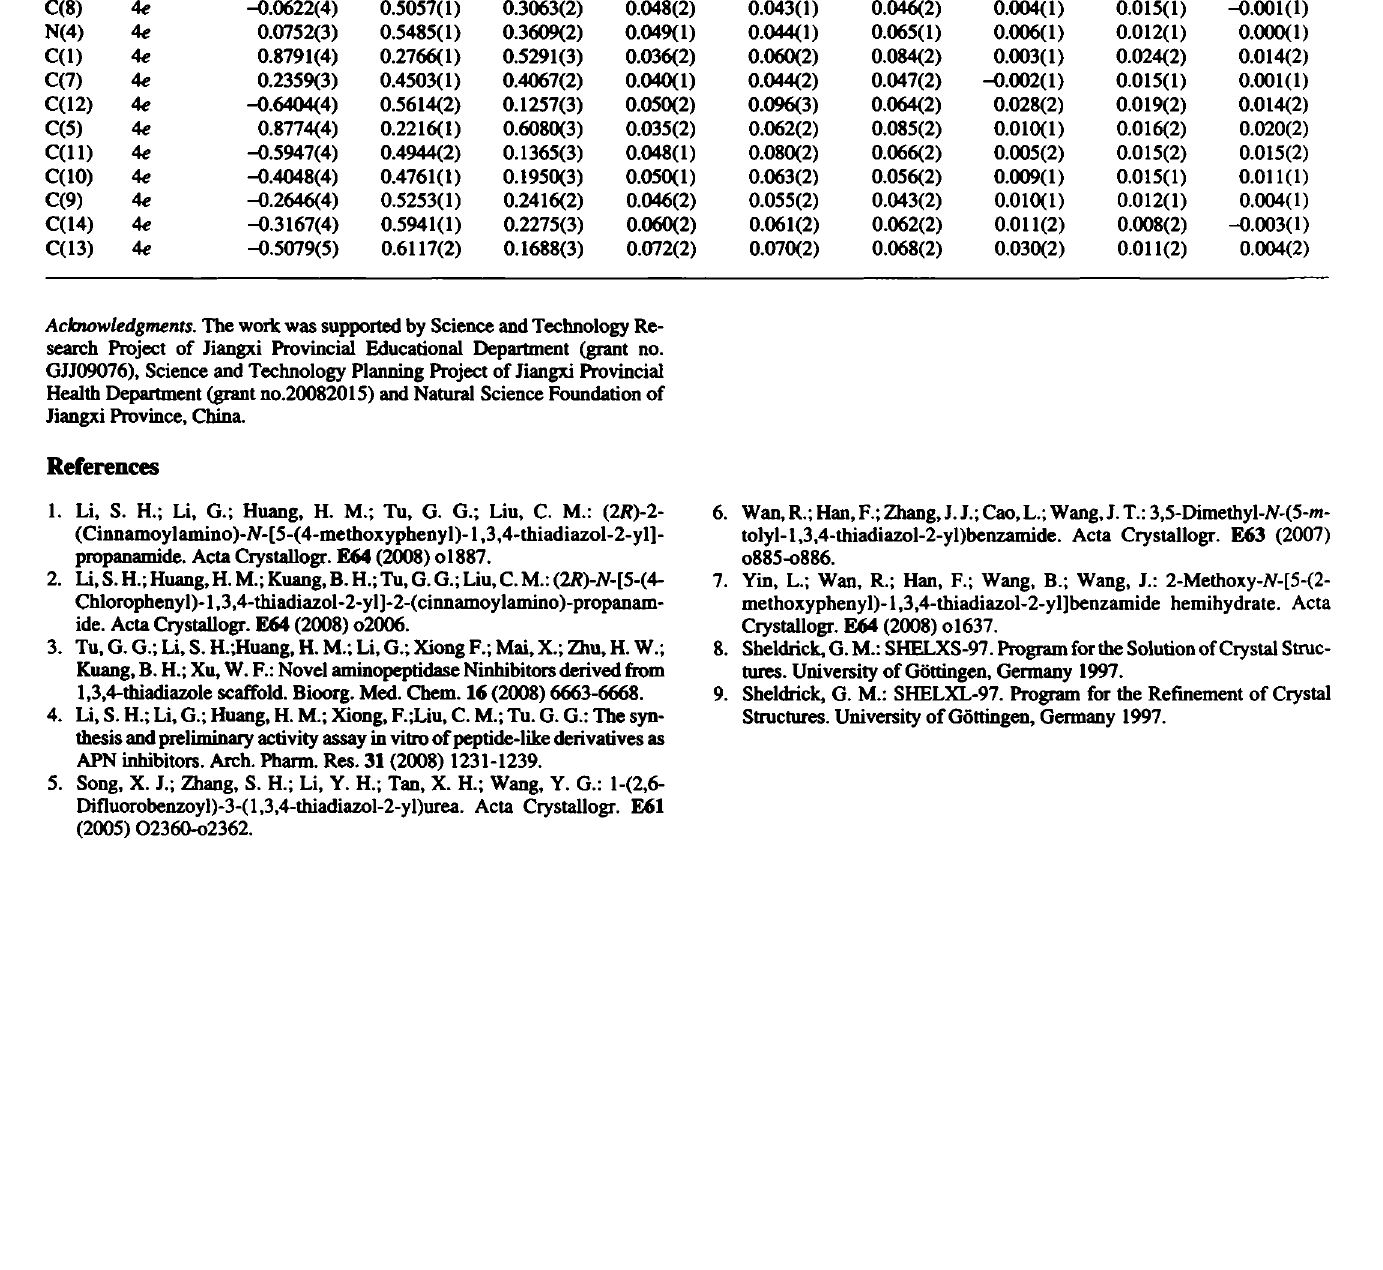
Table 3. Atomic coordinates and displacement parameters (in Ä 2